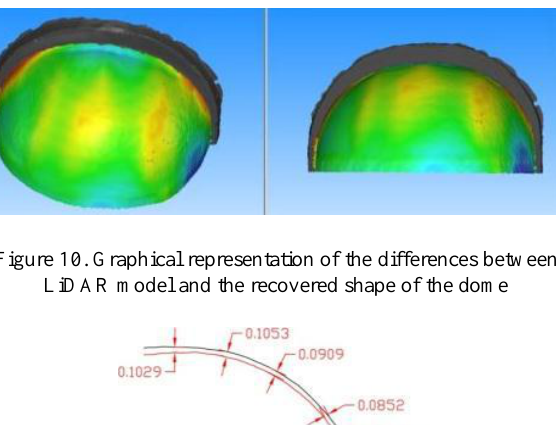
Figure 9. Shaded and textured 3D model of the existing apse